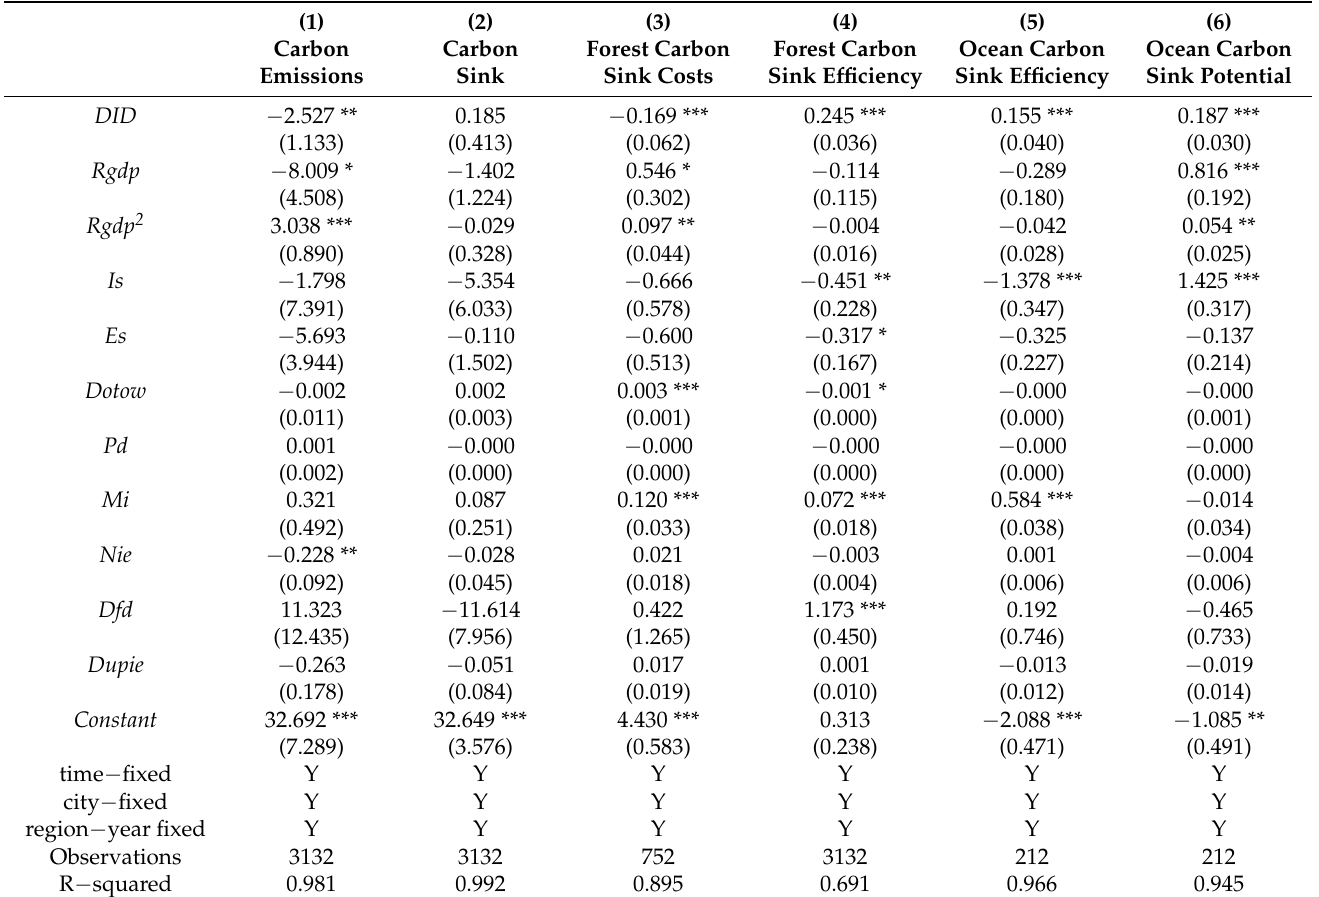
Table 6. Carbon emissions, carbon uptakes, and other carbon